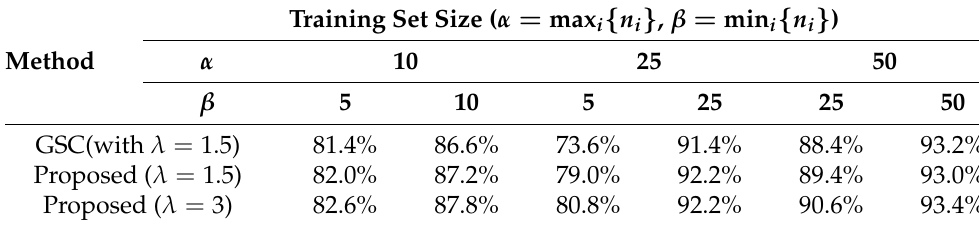
Table 1. Recognition results on the USPS database.